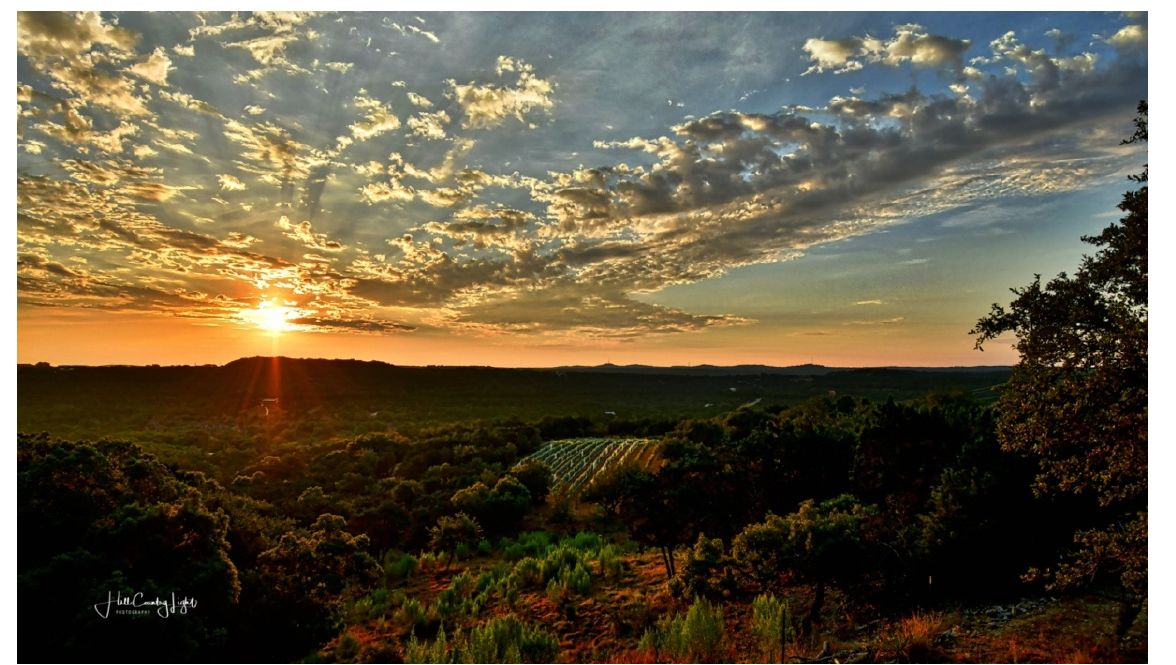
Figure 2. “Harvest Sunrise”, picturing Hill Country AVA, Dripping Springs, TX, at Hawk’s Shadow Winery and Vineyard. (Photo by Hill Country Light Photography, Miguel Lecuona; September 2020).